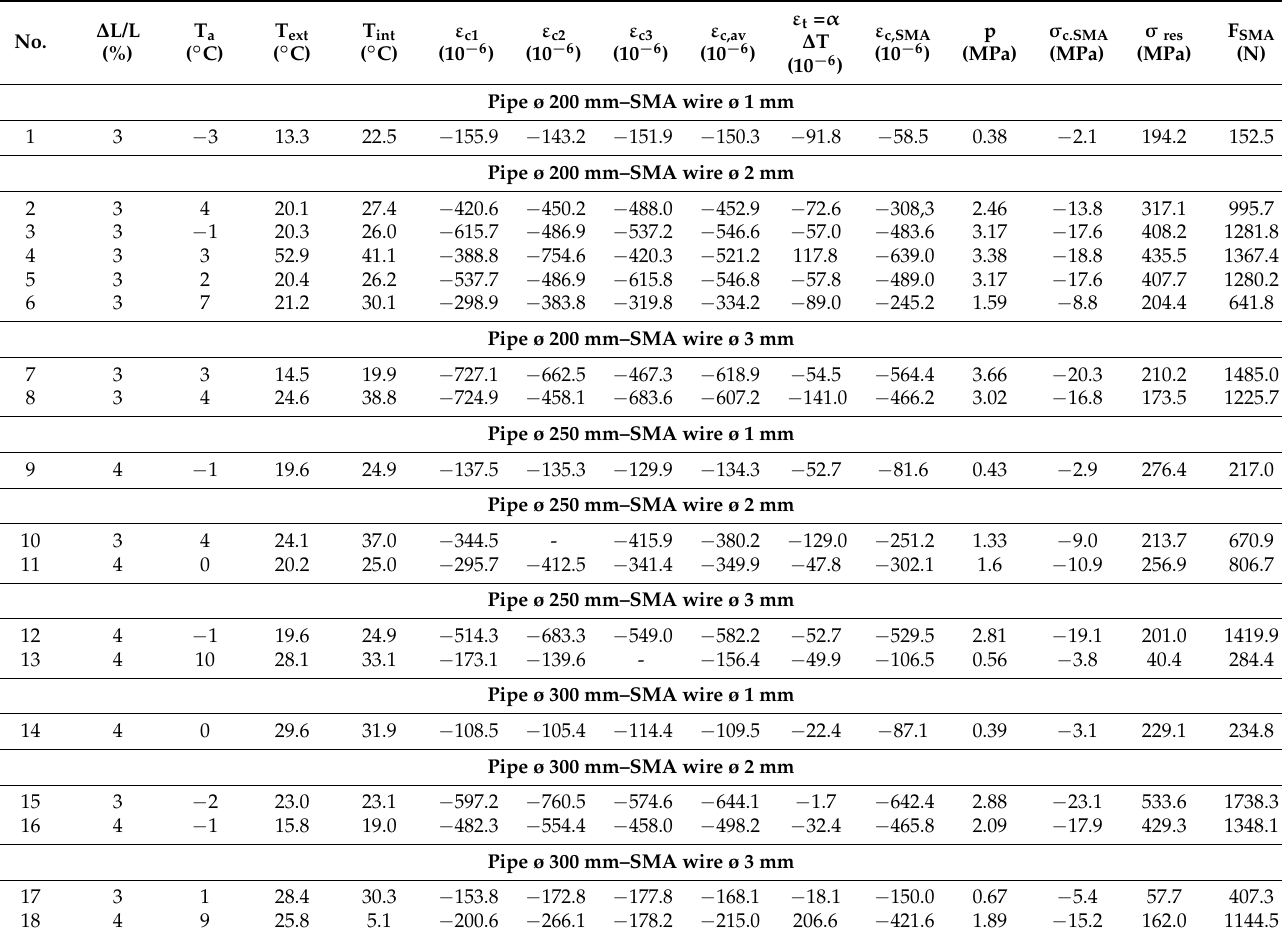
Table 5. Results of measurements and calculation of mean forces in SMA wires wound on the concrete